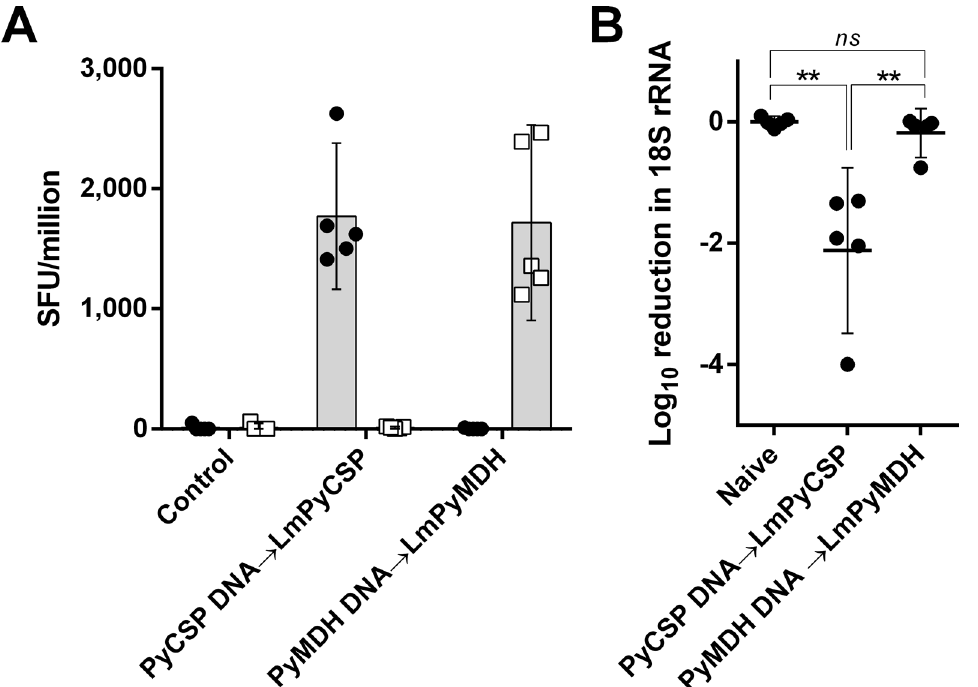
Fig 6. High frequency IFN γ -producing PyMDH-specific T cells do not protect against sporozoite challenge. BALB/cj mice were DNA gene gun vaccinated against Class I epitopes from PyCSP or PyMDH and boosted 21 d later with 5x10 6 cfu attenuated Listeria monocytogenes expressing the same epitope. Mice were challenged with 1x10 4 PyWT sporozoites i.v. and sacrificed for spleen and liver harvest 44 hr post-challenge. (A). ELISPOT performed on splenocytes at the 44 hr time point reflects the frequency of antigen-specific T cells at the time of challenge. Circles, PyCSP peptide; squares, PyMDH peptide; bars indicate mean and 95% confidence interval. (B). Liver stage infection was monitored by Plasmodium 18S rRNA RT-PCR. Bars indicate mean and 95% CI for Plasmodium 18S rRNA normalized to mouse GAPDH mRNA content; ** p < 0.01 (Student ’ s t-test).